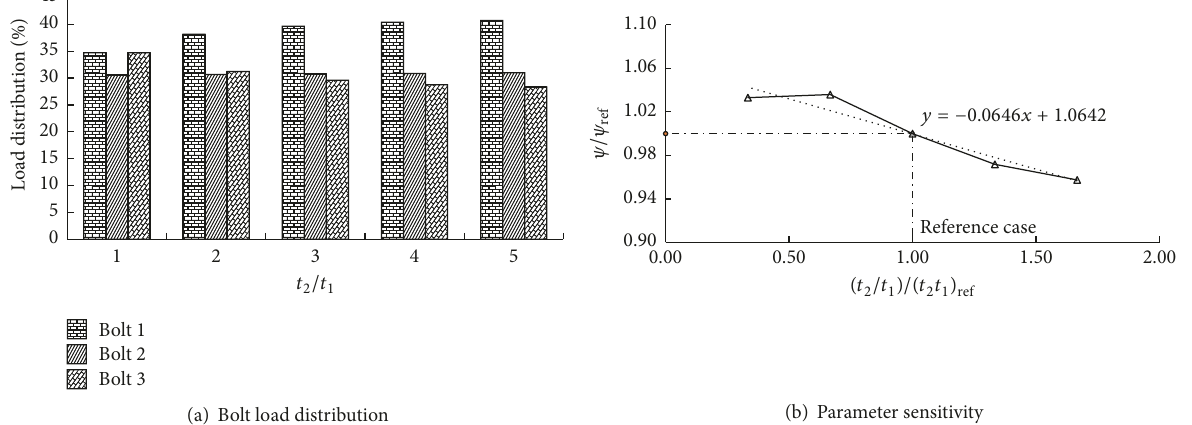
Figure 24: Bolt load distribution and sensitivity analysis results of varying plate thickness.